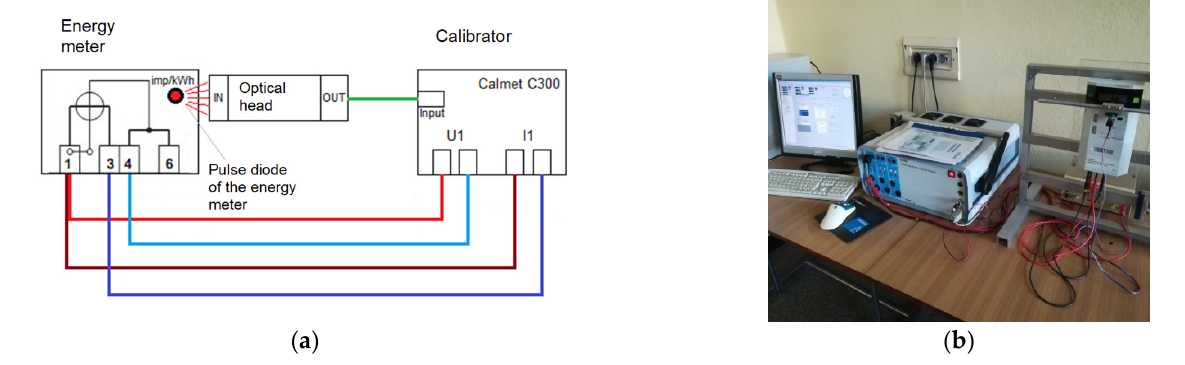
Figure 3. Set-up for measuring errors in the electronic energy meters: ( a ) a block diagram of the set-up; and ( b ) an image depicting the actual set-up.